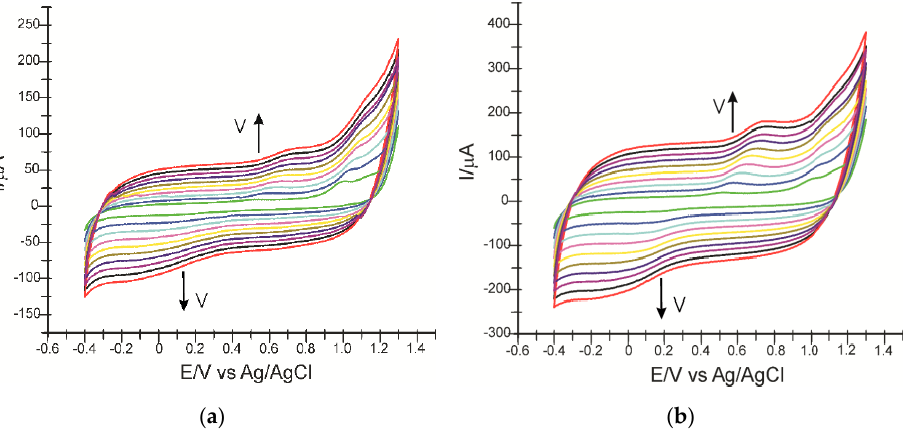
Figure 5. Cyclic voltammograms recorded by ( a ) SPCE and ( b ) AuNP-CNT/SPCE in atorvastatin 3 × 10 − 5 M solution (electrolyte KCl 10 − 1 M solution) at scan rates ranging from 0.1 V/s to 1.0 V/s. Assessing the two linear dependences, one notes that the better linearity and a de- termination factor (R 2 ) closer to 1 was obtained between the intensity of the anodic cur- rent and scan rate, as evident from Figure 6. This trend was observed for both sensors.